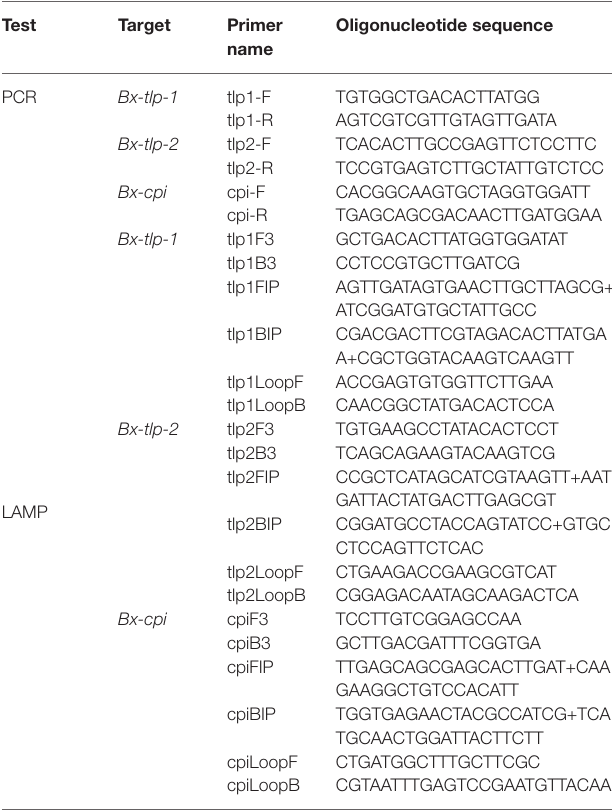
TABLE 1 | Sequences of the primers used to detect nematode and beetle